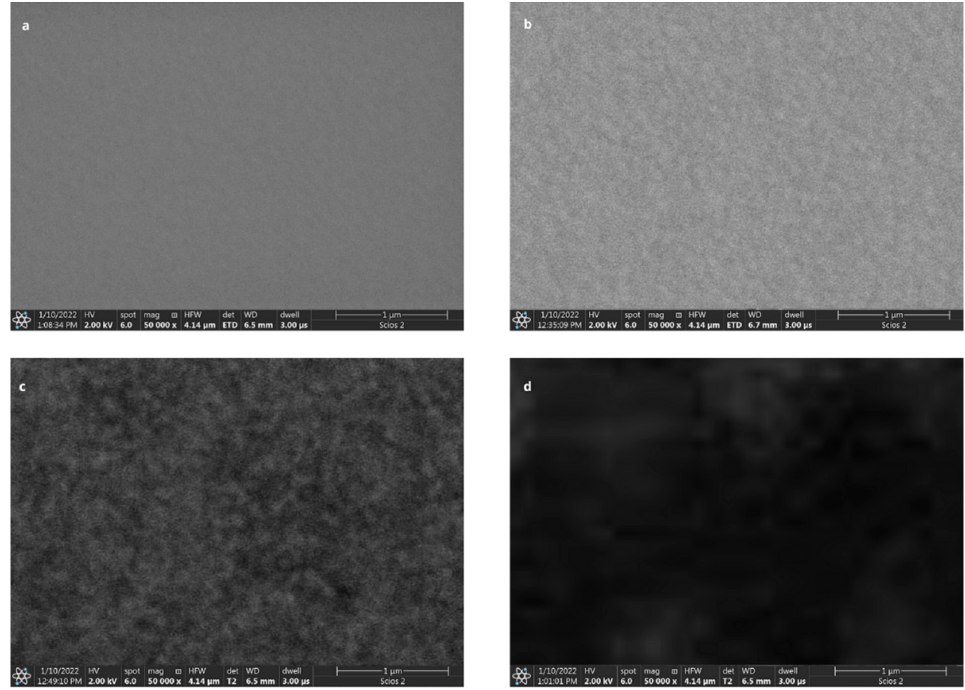
Figure 3. Scanning electron microscope images of the biosensor showing the process of monolayer formation on its surface: ( a )—gold, ( b )—cysteamine, ( c )—antibody, ( d )—PARP-1 protein (HV = 2.00 kV, mag = 50,000×, HFW = 4.14 µm).